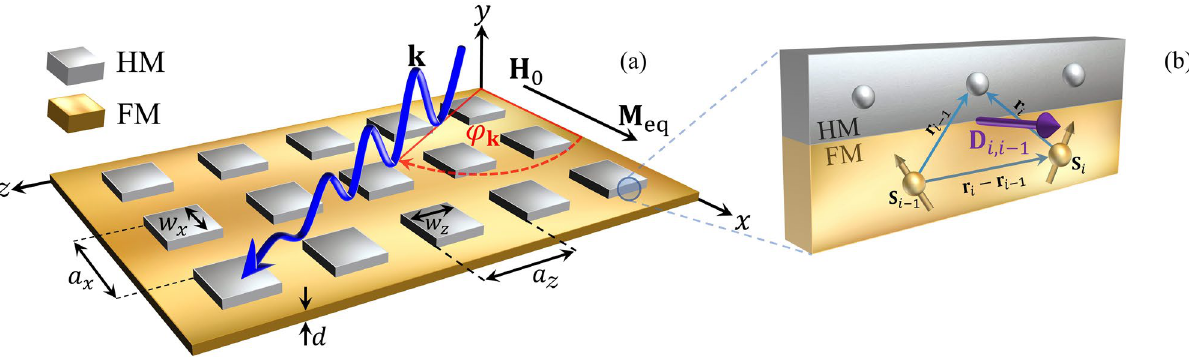
Figure 1. ( a ) Illustration of a ferromagnetic ultrathin film of thickness d = 3 nm in contact with a periodic array of heavy-metal islands, which induce an interfacial Dzyaloshinskii–Moriya interaction only below the HM. In this 2D chiral magnonic crystal, the spin waves propagate with a wave vector k in the x-z plane with a given angle ϕ k . The equilibrium magnetization points along x due to an external magnetic field applied in the same direction. ( b ) The scheme depicts the notation used to describe the interfacial Dzyaloshinskii–Moriya interaction, where two atomic spins interact through a third Pt atom (gray sphere) at position r i concerning spin i and the corresponding DM vector between